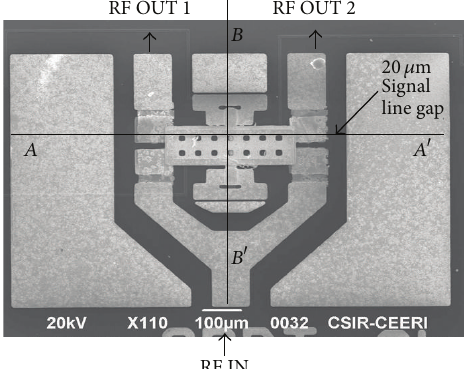
Figure 2: SEM image of a spring-free see-saw RF MEMS capacitive switch.